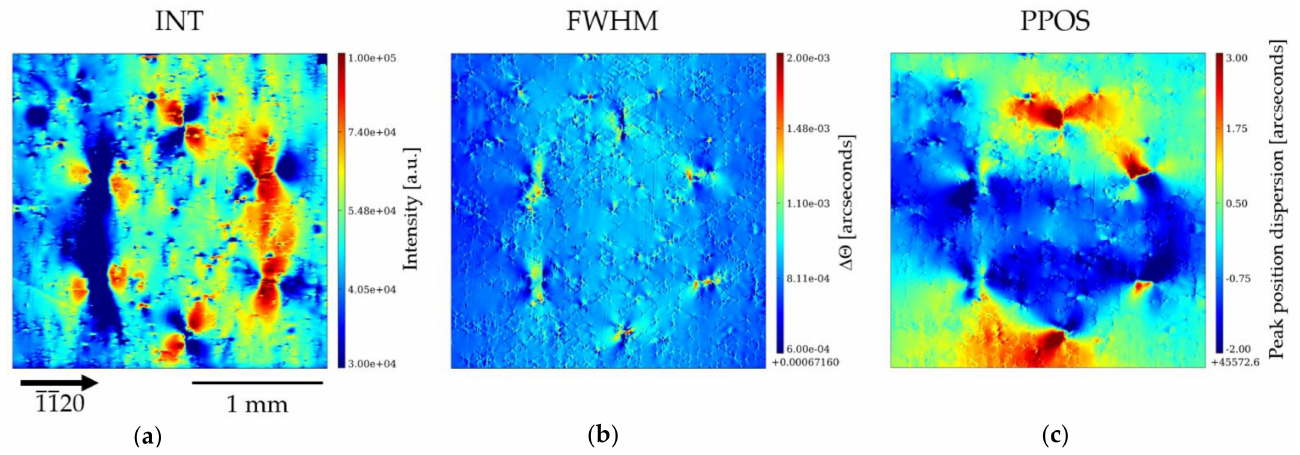
Figure A2. RCI maps of the 1120 reflection at 18 keV: ( a ) integrated intensity map (INT); ( b ) full-width at half-maximum map (FWHM); ( c ) peak position map (PPOS) (compare to Figure